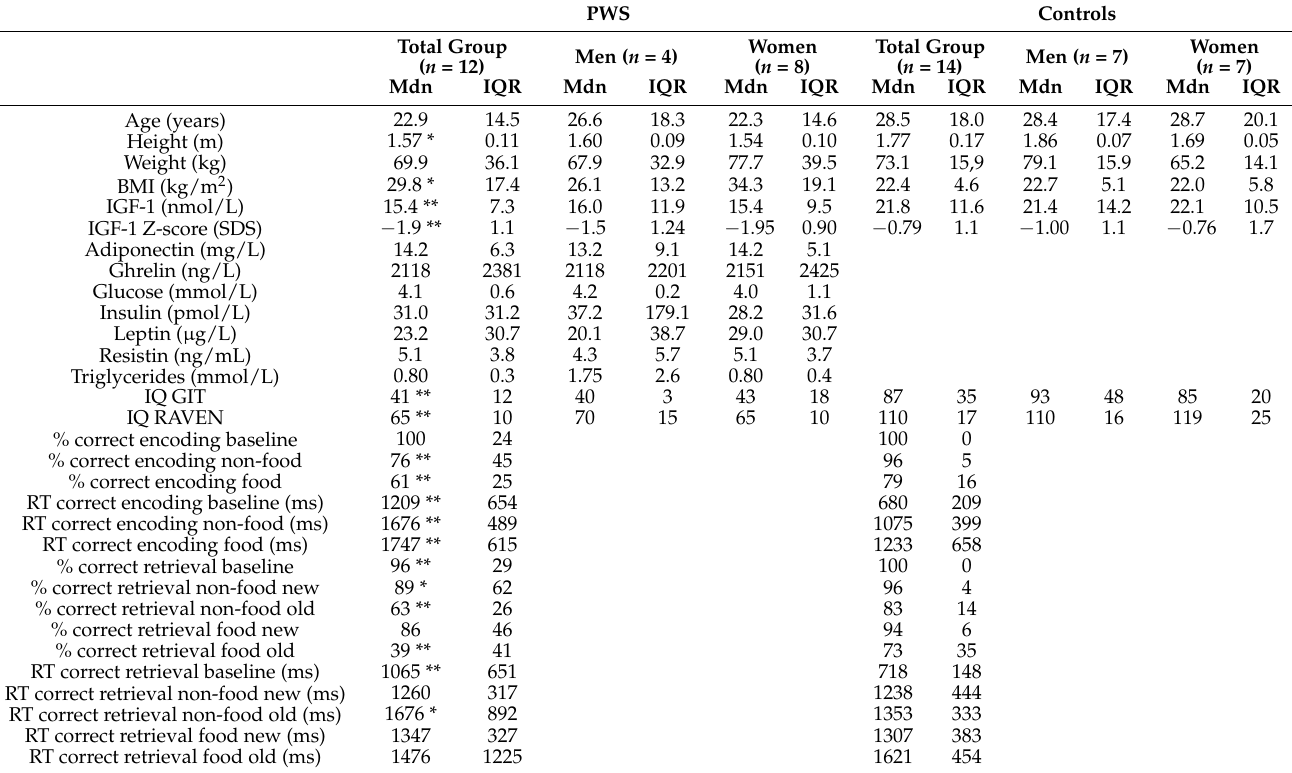
Table 1. Baseline characteristics and psychometric measurements of the fMRI task.